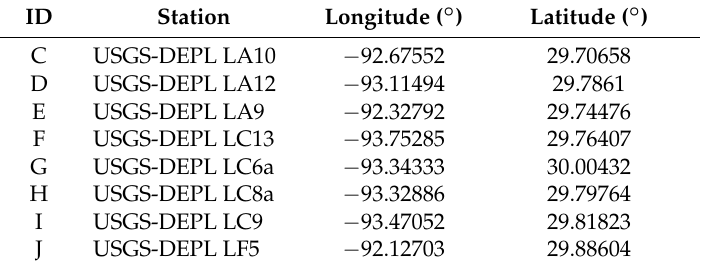
Table 2. Locations of United States Geological Survey (USGS) Deployed (DEPL) observation stations. Note: LA10, LC13, LF5, etc. are identification tags for station